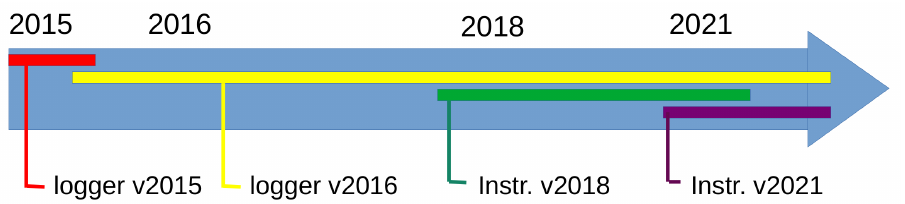
Figure 2. Full lineage of our present open-source instrument. Developing reliable autonomous instruments is a long-term effort. The development of our instrument can be tracked back to 2015 [41] and 2016 [21], though the instruments used at the time were simple loggers. Using loggers is still an attractive solution when the instruments can be recovered, and the logger v2016 design is still in use today. By contrast, our first truly autonomous, satellite-enabled instrument was designed in 2017–2018 [51], and the present instrument is the second iteration around this